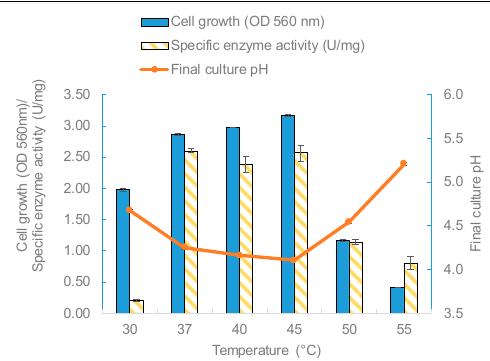
Figure 4. The effect of growth temperature on biomass and enzyme production. The bacteria were grown statically (0 rpm) in 20mL of MRS broth placed in 30 mL capacity universal media glass bottles. Results are shown as the mean ± standard deviation of three independent experiments.